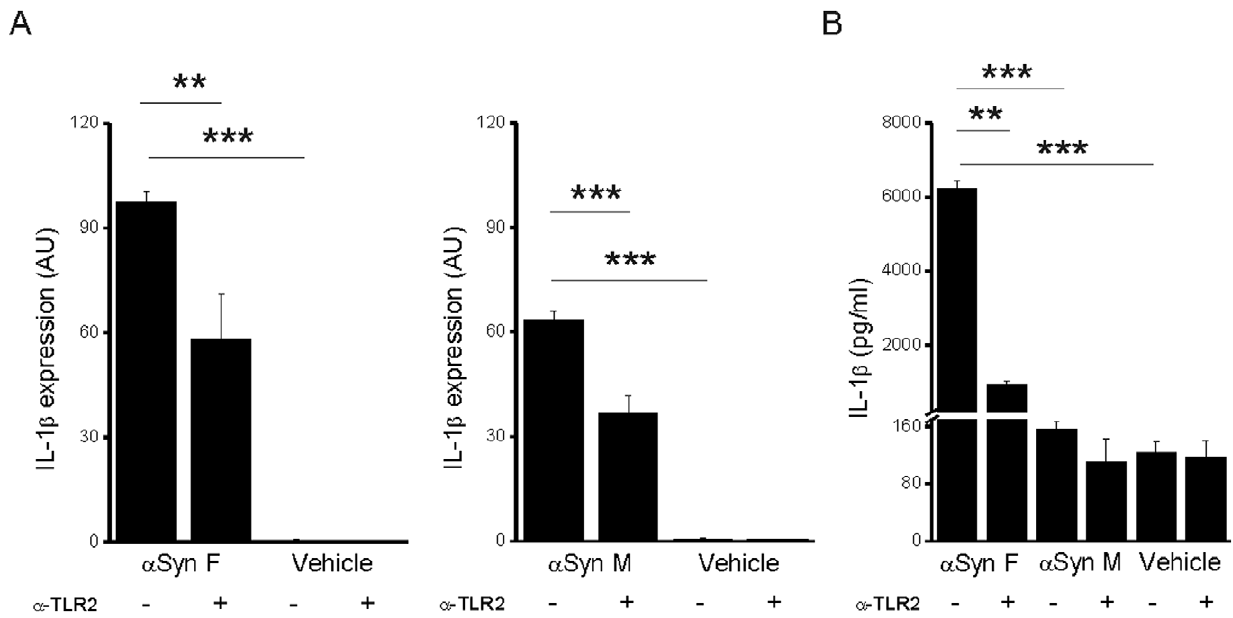
Figure 6. TLR2 engagement is involved in IL-1 b induction by a Syn. (A) Levels of pro-IL-1 b mRNA in monocytes were determined by quantitative real-time PCR analysis after a 6 h stimulation with a Syn F or a Syn M in the presence or not of a soluble anti-TLR2 antibody. Real time data are shown as the mean 6 S.D. of results obtained with 2 cell preparations obtained from 2 different donors; experiments with each cell preparation was conducted in duplicate. (B) IL-1 b content in the culture supernatant of the same cells harvested for mRNA evaluation was determined by ELISA. Results are the mean 6 S.D. of 2 experiments conducted in duplicate with cell preparations obtained from 2 different donors. ** p , 0.01 and *** p ,